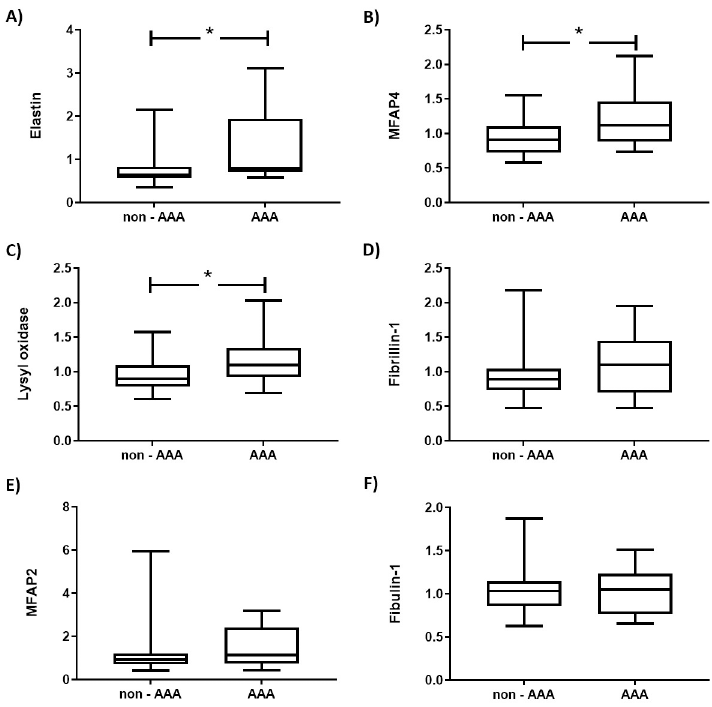
Fig 2. The relative amounts of elastin-related arterial proteins. Elastin (A), MFAP4 (B), lysyl oxidase (C), fibrillin-1 (D), MFAP2 (E) and fibulin-1(F) in patients without abdominal aortic aneurysm (non-AAA) or with abdominal aortic aneurysm (AAA). Data are presented as median, interquartile and range (cid:3) indicates p < 0.05 (without correction for multiple testing).